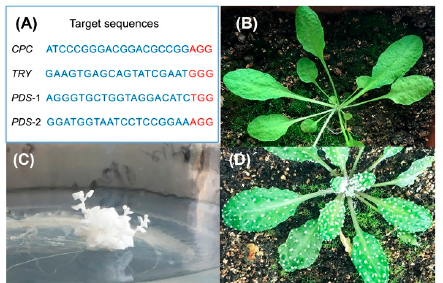
Figure 3. Arabidopsis T1 mutants obtained via CRISPR/Cas9. ( A ) Target sequences for constructing CRISPR/Cas9-edited mutants. The 19 nt target sequences and the following PAMs (NGG) are highlighted in blue and red, separately. ( B ) The phenotype of wild-type Arabidopsis . ( C ) The phenotype of CRISPR/Cas9-edited PDS mutant. ( D ) The phenotype of CRISPR/Cas9-edited TRY and CPC